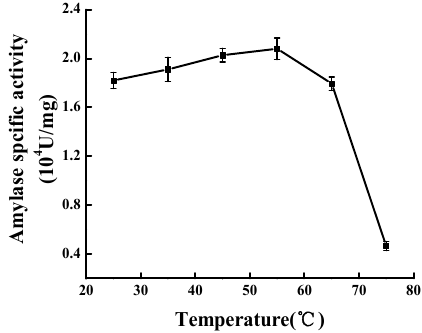
Figure 3. Effect of modification temperature on modification.